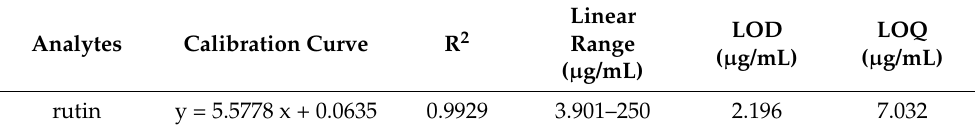
Table 1. Calibration curve, correlation coefficient, LOD, and LOQ of the total flavonoids.